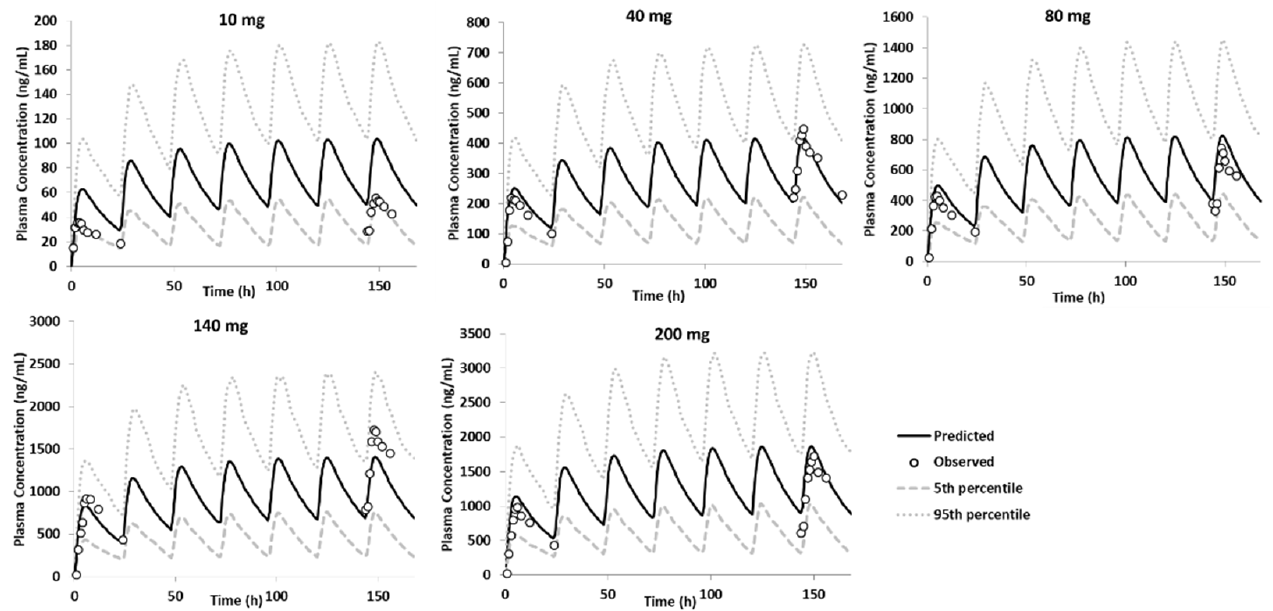
Figure 11. Performance verification of the PBPK model in fed state using the DLM model; overlay observed individual data from phase IIa study—10, 40, 80, 140 and 200 mg—IR tablet—single dose daily after a moderate–high fat meal [2].